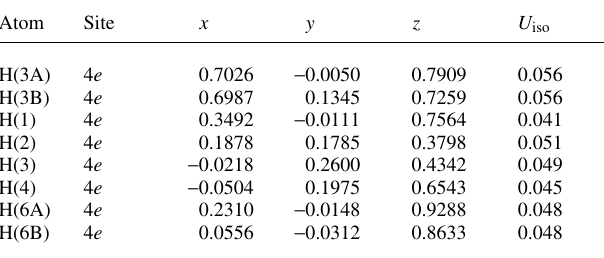
Table 2. Atomic coordinates and displacement parameters (in Å 2 )